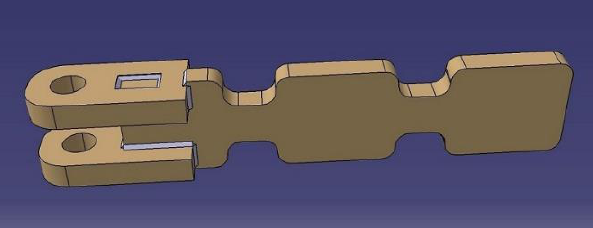
Figure 7. Welded crushing hammer.